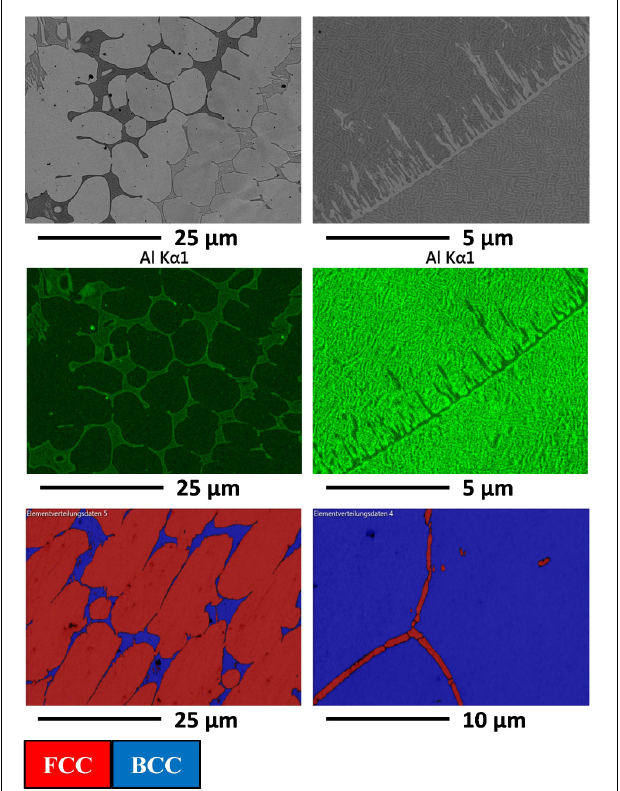
FIGURE 7 | EDS Al maps and EBSD phase maps of sample positions 2 (left) and 5